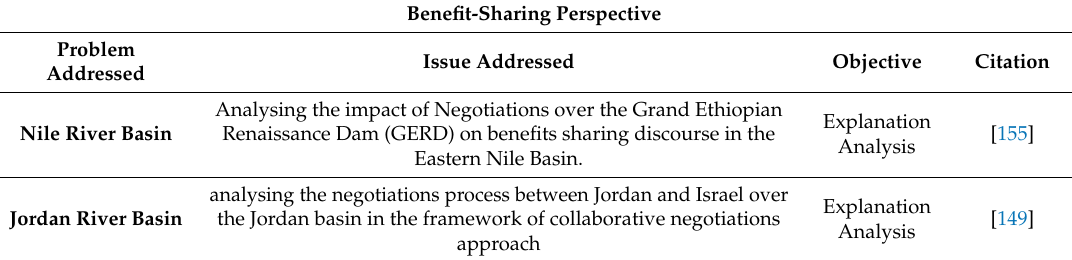
Table 7. Benefit-sharing Mechanism—Theory and